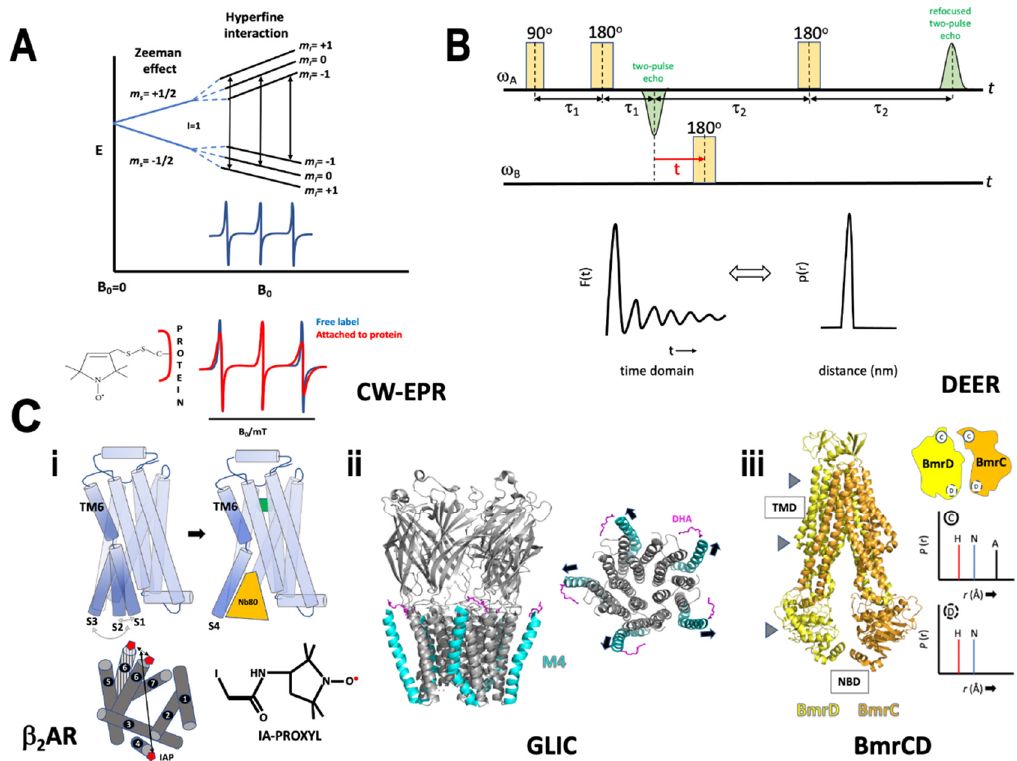
Figure 5. ( A ) Energy level diagram of MTSL. Interaction of the nuclear and electron spins causes further splitting of the spin system with different energy levels known as hyperfine interaction. EPR spectrum of the free spin label (blue) overlaid onto the spectrum of spin label conjugated to a protein (red), bottom panel. ( B ) The DEER four-pulse sequence. For interacting spins, the modulation observed from the refocused echo in the time domain is directly used to measure distances using model-independent analysis. ( C ) (i) The various states of TM6 in β 2 AR. Inactive states (S1, S2); active intermediate state S3 in the presence of agonist (green); and active state S4 with Nb80. Positions of spin-label, IA-PROXYL on TM4 and TM6 for EPR measurements are shown in red. (ii) Structure of GLIC (PDB 5J0Z) highlighting the outermost helix M4 (blue) that interacts with DHA (magenta). Top view without the extracellular domain showing the outward movement of M4. (iii) Structure of BmrCD (PDB 7M33) with protomers BrmD (in yellow) and BmrC (in orange). Arrows indicate position of spin labels. Schematic showing the consensus (C, solid circle), and degenerate NBS (D, broken circle) along with a schematic of DEER distance measurements indicating the presence of HES (H), nucleotide bound (N) and apo (A) conformational states for each of the NBSs.